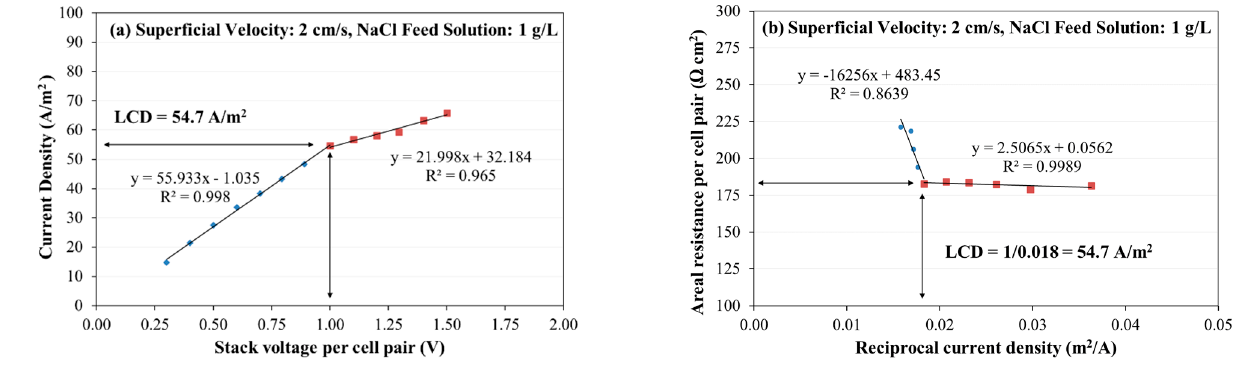
Figure 2. LCD determination using ( a ) Shoulder plot and ( b ) Cowan–Brown